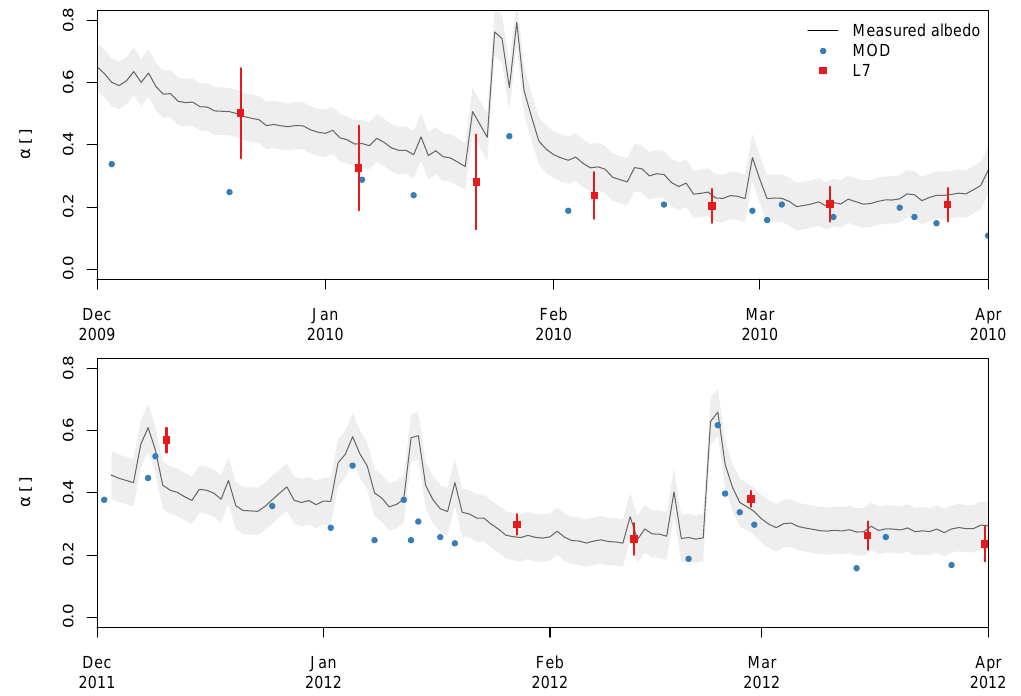
Figure 11. Seasonal evolution of broadband albedo on Glaciar Tapado for the ablation seasons 2009/2010 (a) and 2011/2012 (b) . The solid lines are arithmetic means of hourly values (slope corrected) between 10:00 and 11:00 LST for every day at the AWS, whereas the grey shaded area is the 95% confidence interval for the AWS data. The blue dots represent the MODIS (MOD: 10:30LST Terra overpass at the Equator) and the red squares the Landsat (10:00LST overpass at the Equator) derived albedos with the 95% confidence interval for the nine pixels surrounding the